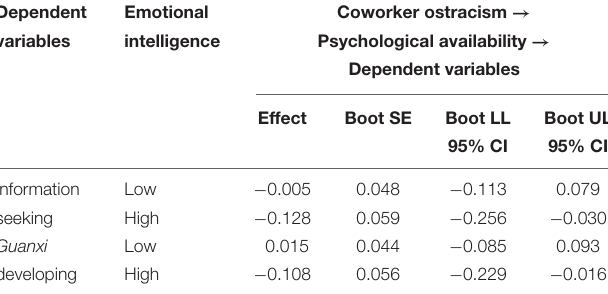
TABLE 6 | Results of the moderated path